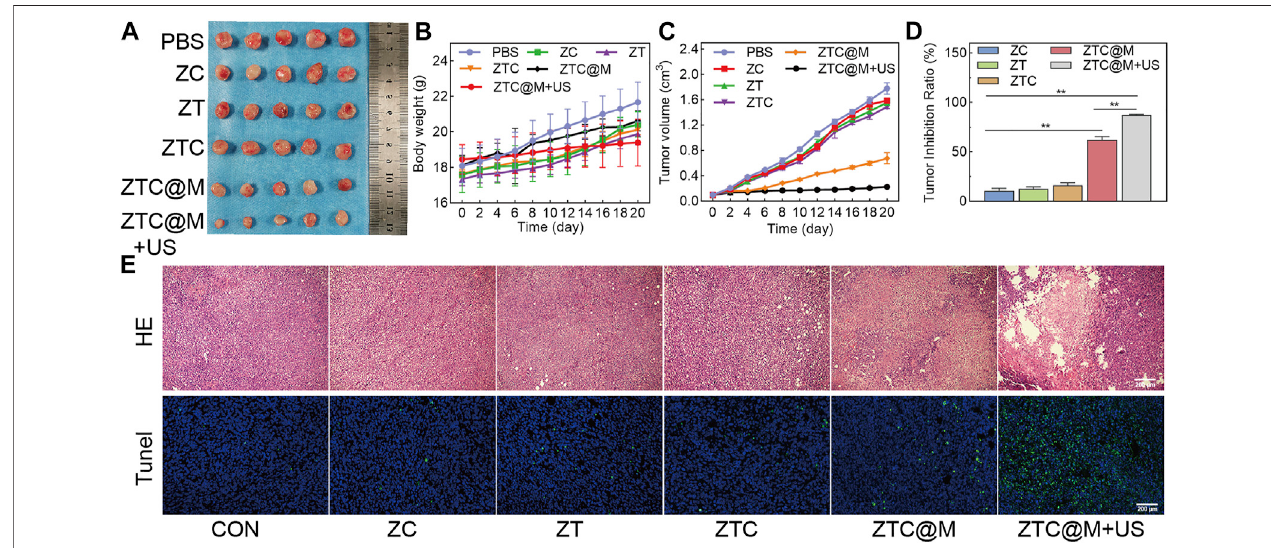
FIGURE 8 | In vivo SDT. Photos of tumor (A) , tumor volume change (B) , body weight change (C) , and tumor inhibition rate (D) of AGS tumor-bearing nude mice with different treatments. H&E and TUNEL staining of tumor after different treatments (E) (100×). n = 5. * p < 0.05, ** p <